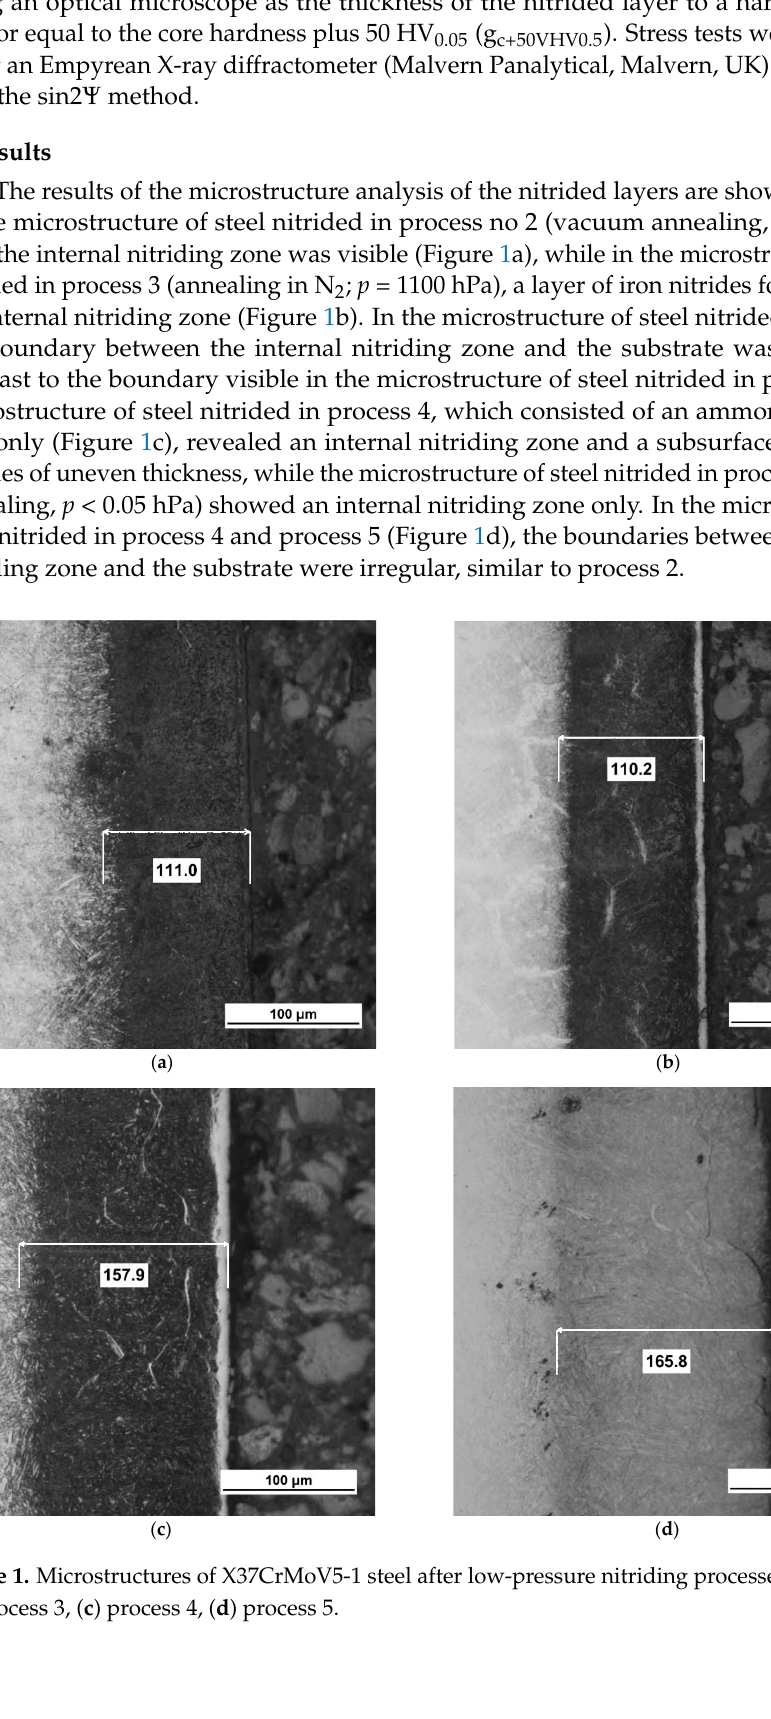
Figure 5) for processes 1–5.